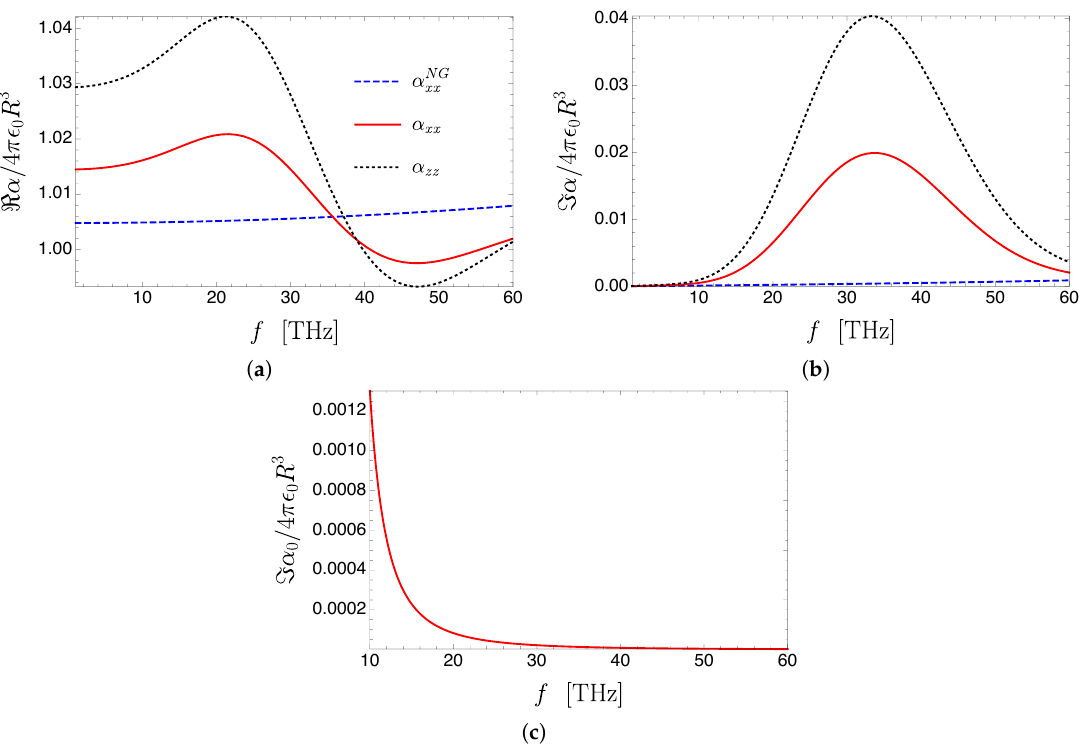
Figure 3. Top panels: Real ( a ) and imaginary ( b ) parts of the renormalized polarizability of a gold nanoparticle with radius R = 50nm located at a distance of z 0 = 151nm from a graphene sheet with a Fermi energy of 1 eV and damping parameter of ¯ h γ = 4.1 meV supported by a dielectric of permittivity (cid:101) 2 = 2. The solid red line represents the xx component, and the black dotted line represents the zz component of the polarizability in the presence of graphene. For comparison, the xx component of the polarizability of the nanoparticle is also represented in the absence of graphene (but in the presence of the dielectric interface), as α NG xx . One can appreciate the increase in the imaginary part of the polarizability by about two orders of magnitude when the particle is near doped graphene. ( c ) The imaginary part of the nanoparticle polarizability in a vacuum. In all the panels, the parameters used in the Drude model for dielectric function of gold are: ¯ h ω p = 7.9 eV and Γ 0 = 0.053